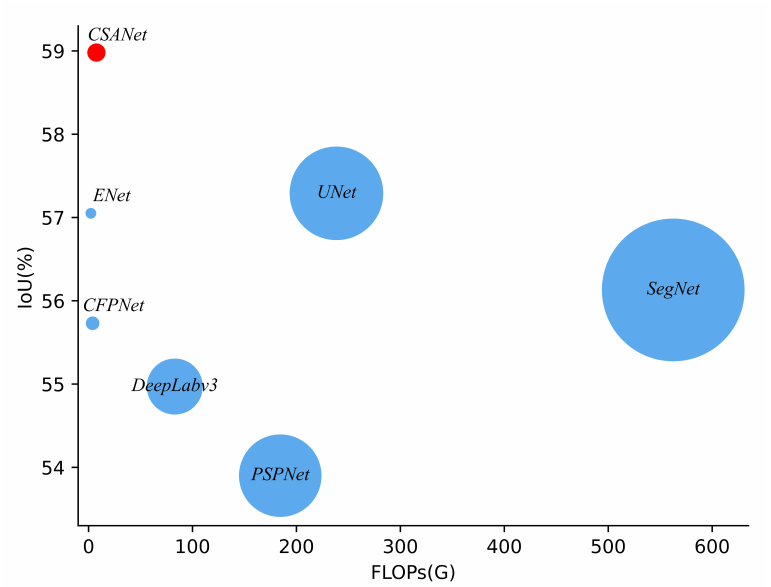
Figure 9. Network FLOPs and IoU accuracy.